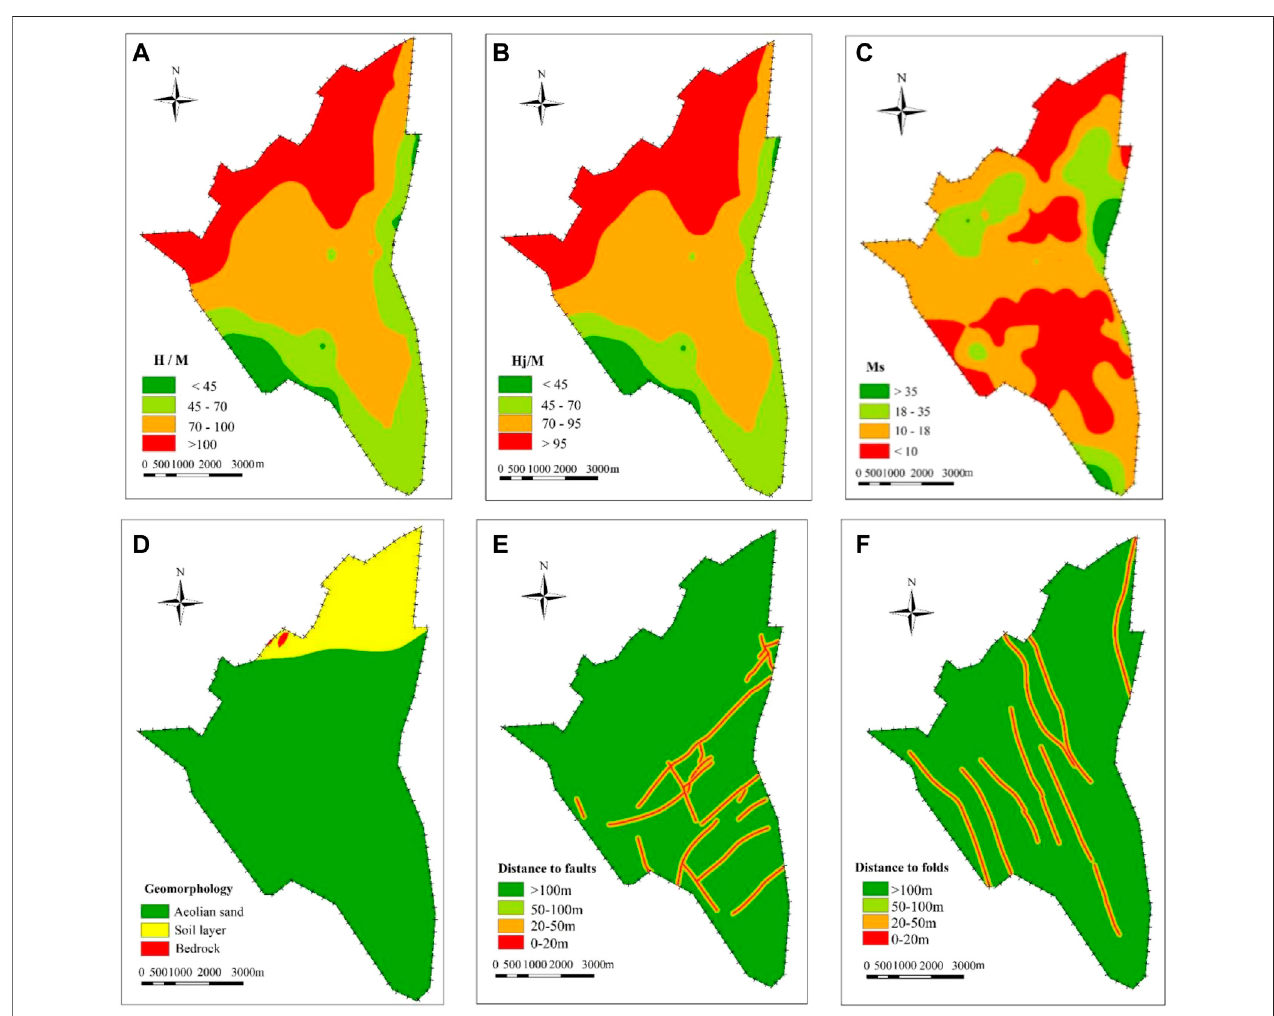
FIGURE 6 | Study area thematic area: (A) H/M, (B) Hj/M, (C) Ms, (D) geomorphology, (E) distance to faults, and (F) distance to folds.